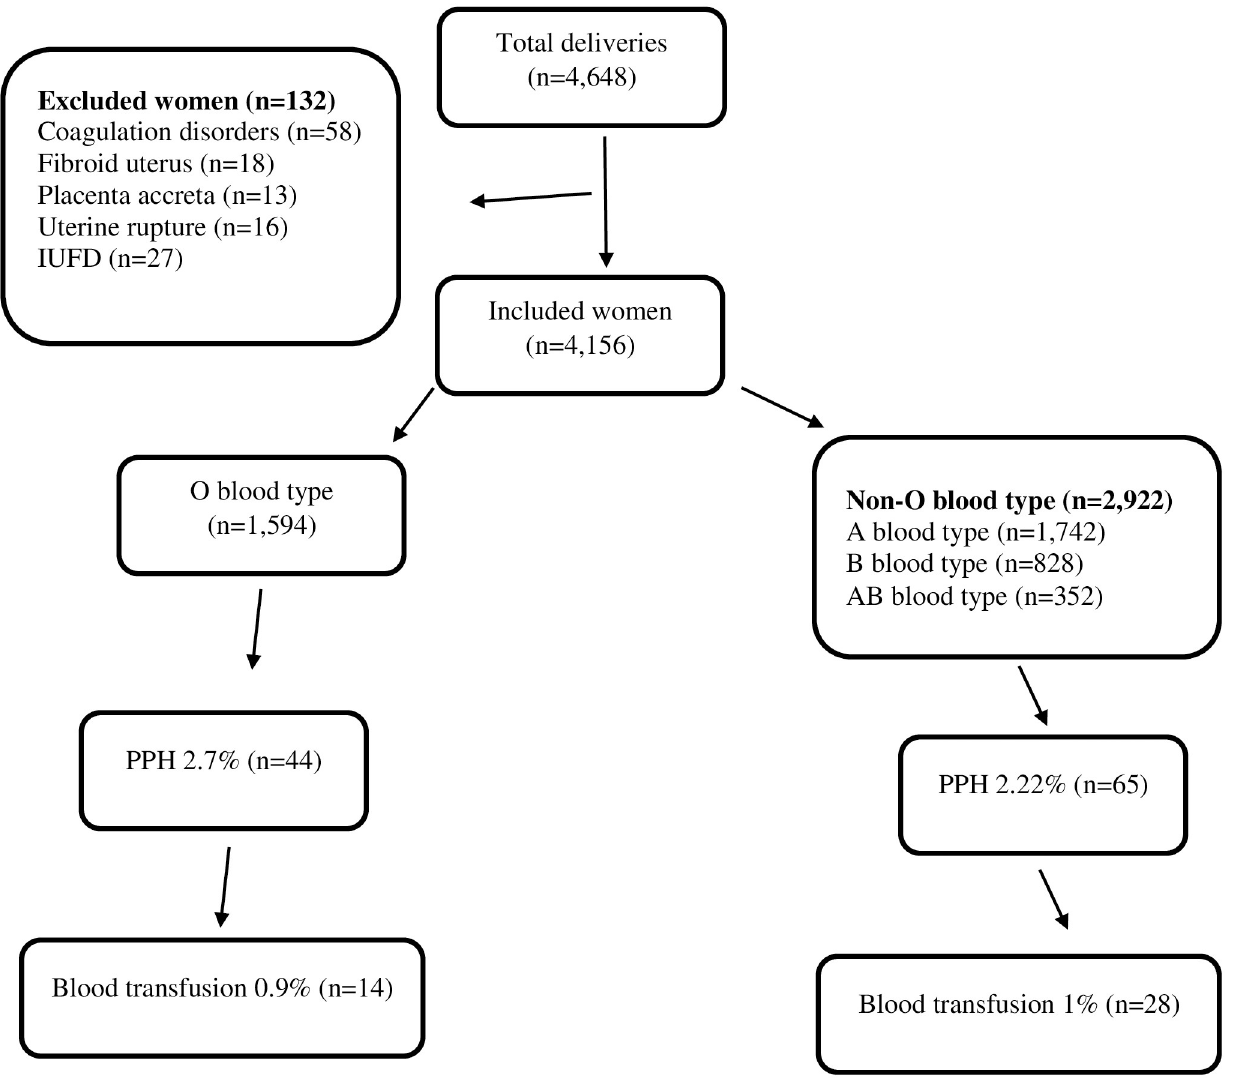
Fig 1. Patients’ recruitment flow